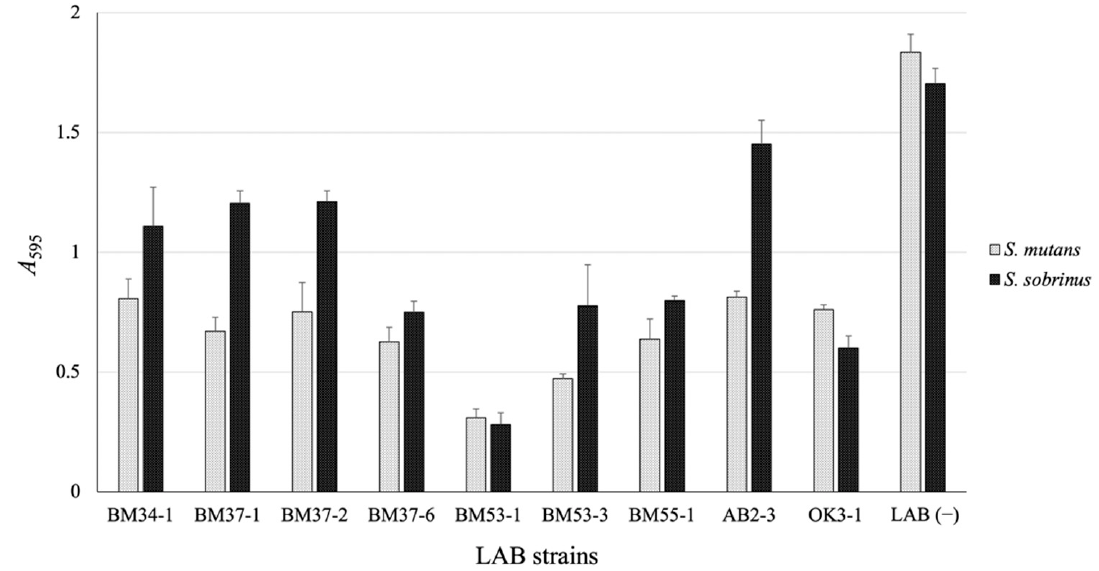
Figure 1. The sticky glucan production by S. mutans or S. sobrinus that have or have not been incubated with members of the LAB library. After the co-cultivation of LAB with S. mutans MT8148R or S. sobrinus ATCC27607, the formed glucan was stained and calculated using the crystal violet method. The data are indicated as means of independent assays with a standard error. LAB ( − ), only S. mutans or S. sobrinus was cultivated without LAB.